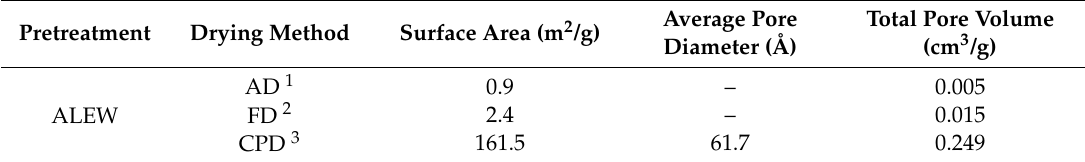
Table 1. Mean surface areas, pore diameters, and total pore volumes for the alkaline electrolyzed water (ALEW) pretreated Eucalyptus samples.